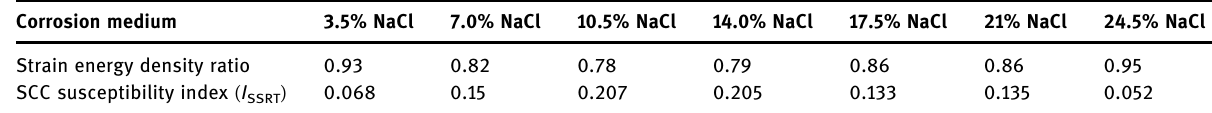
Table 5: SCC sensitivity calculation results of high manganese steel Corrosion medium